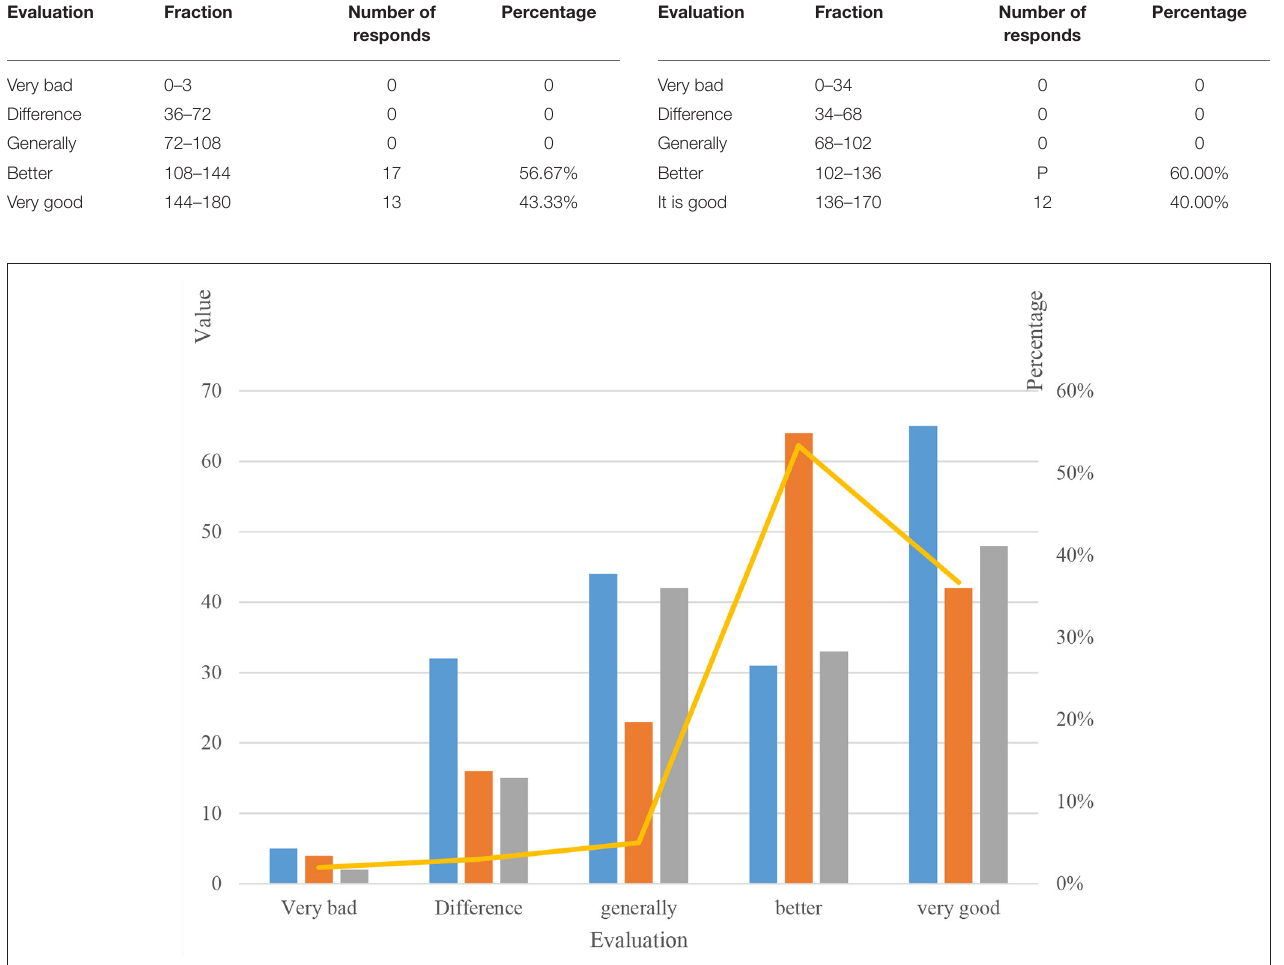
FIGURE 7 | Statistical chart of survey analysis of incentive